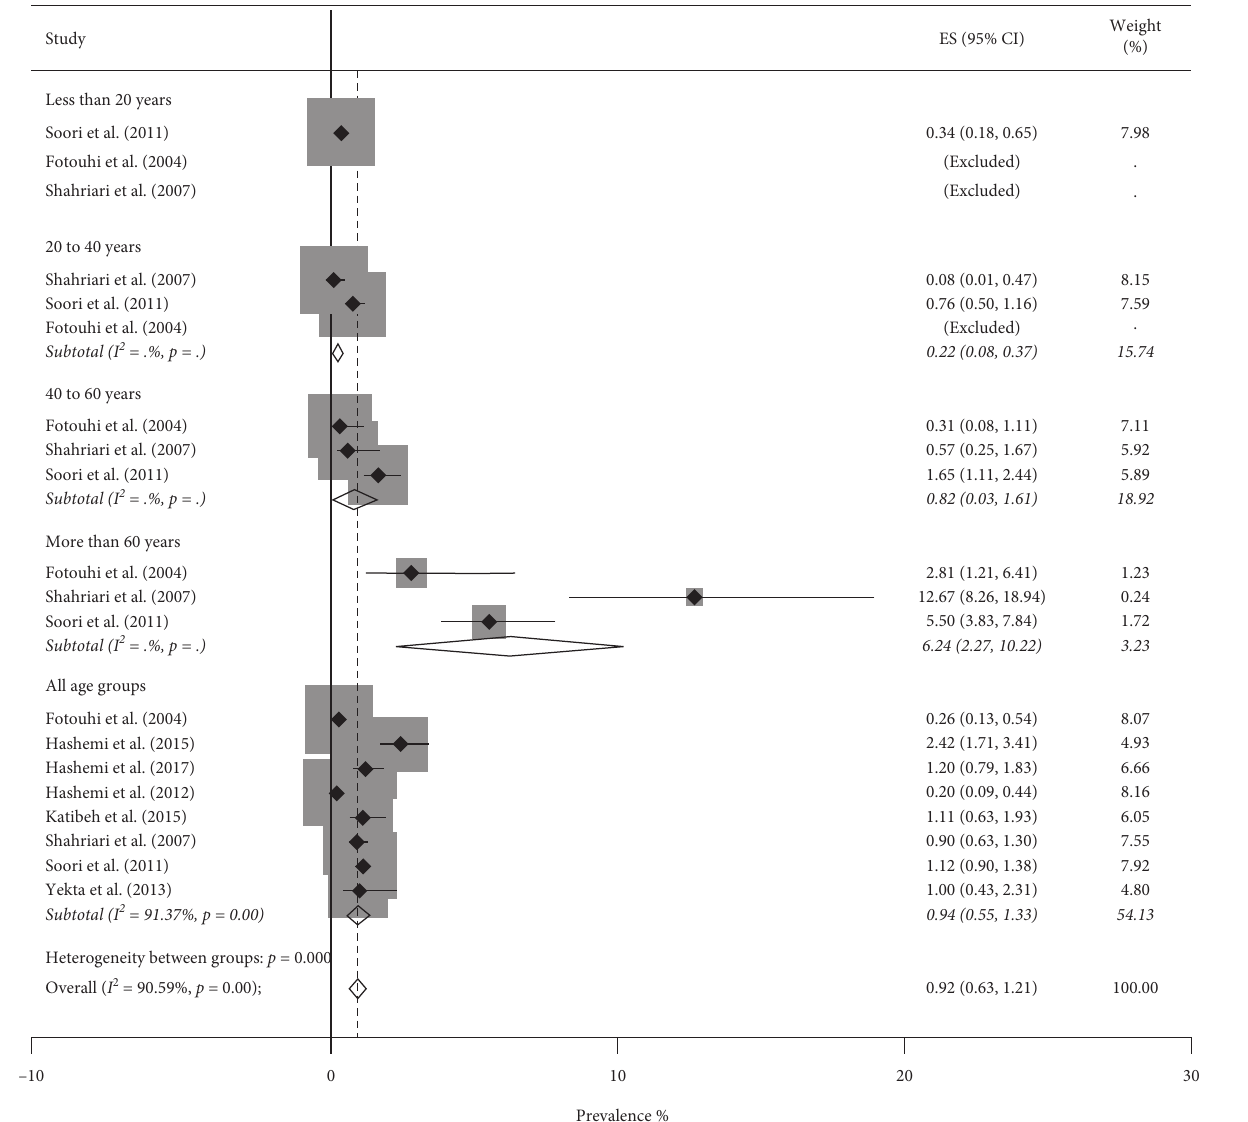
Figure 3: Forest plot of the prevalence of blindness among Iranian